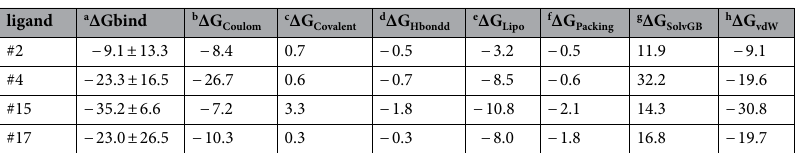
Table 5. Prime MM-GBSA energies for ligands binding at the Omicron Spike RBD. a Total free energy of binding, in kcal/mol as calculated by the MM-GBSA method, averaged over the time of simulation. b Electrostatic Coulomb term of the binding energy. c Covalent term of the binding energy. d Hydrogen bond contribution to the binding energy. e Lipophilic contribution to the binding energy. f π–π packing correction. g Generalized Born term of the solvation energy. h van der Waals term of the binding energy.